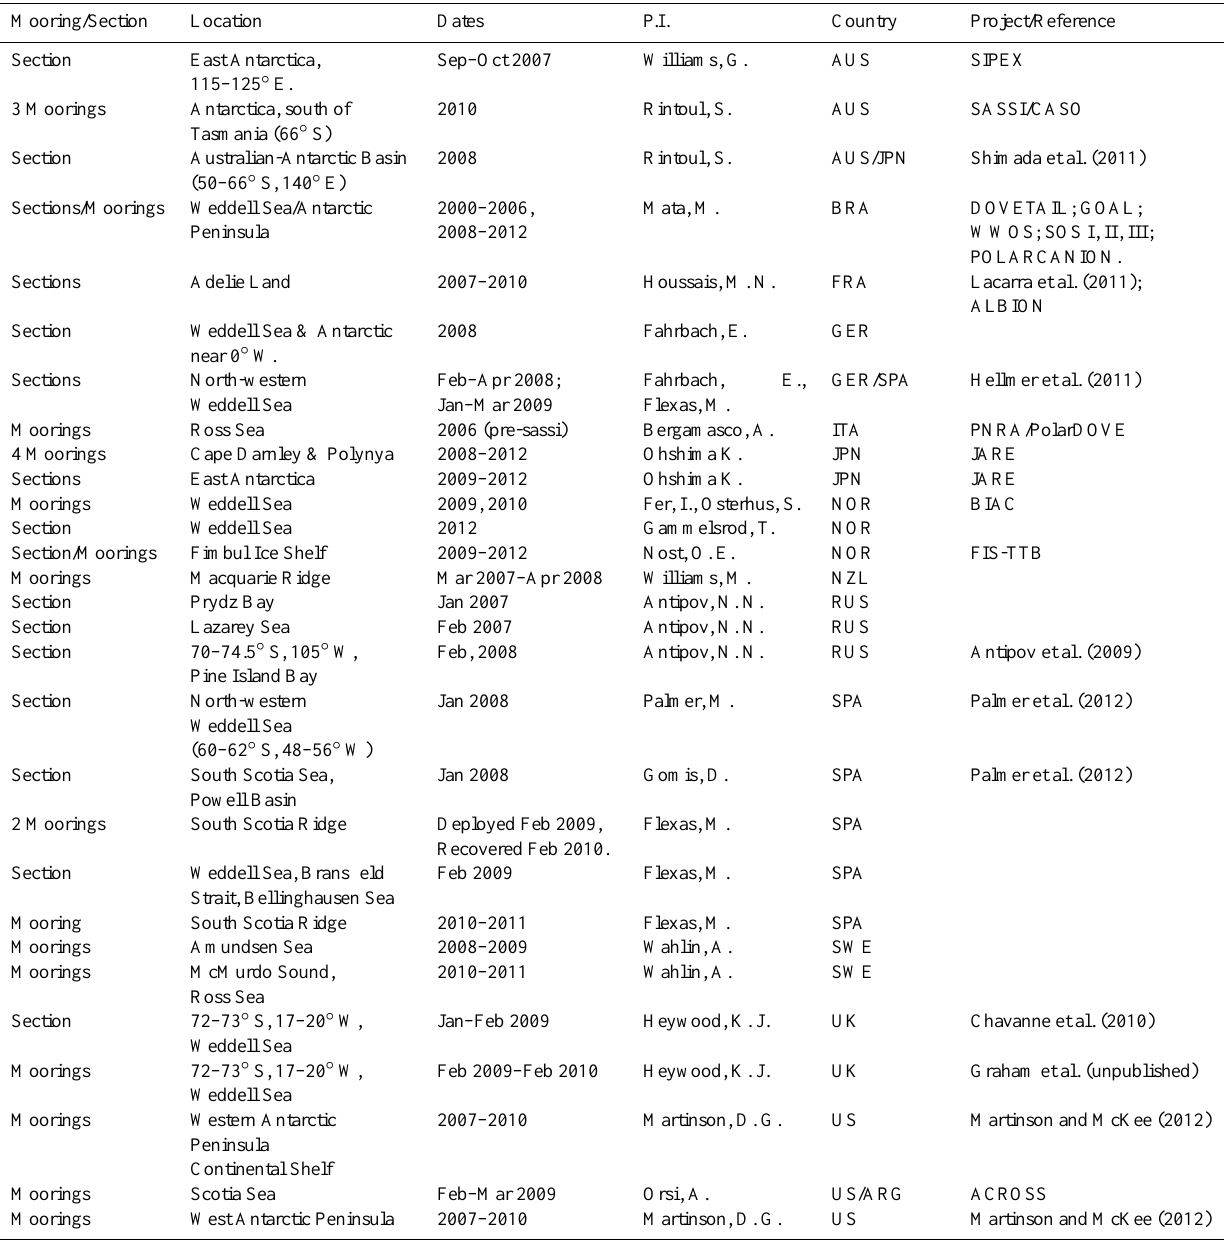
Table 1. Moorings and Sections contributing to the SASSI